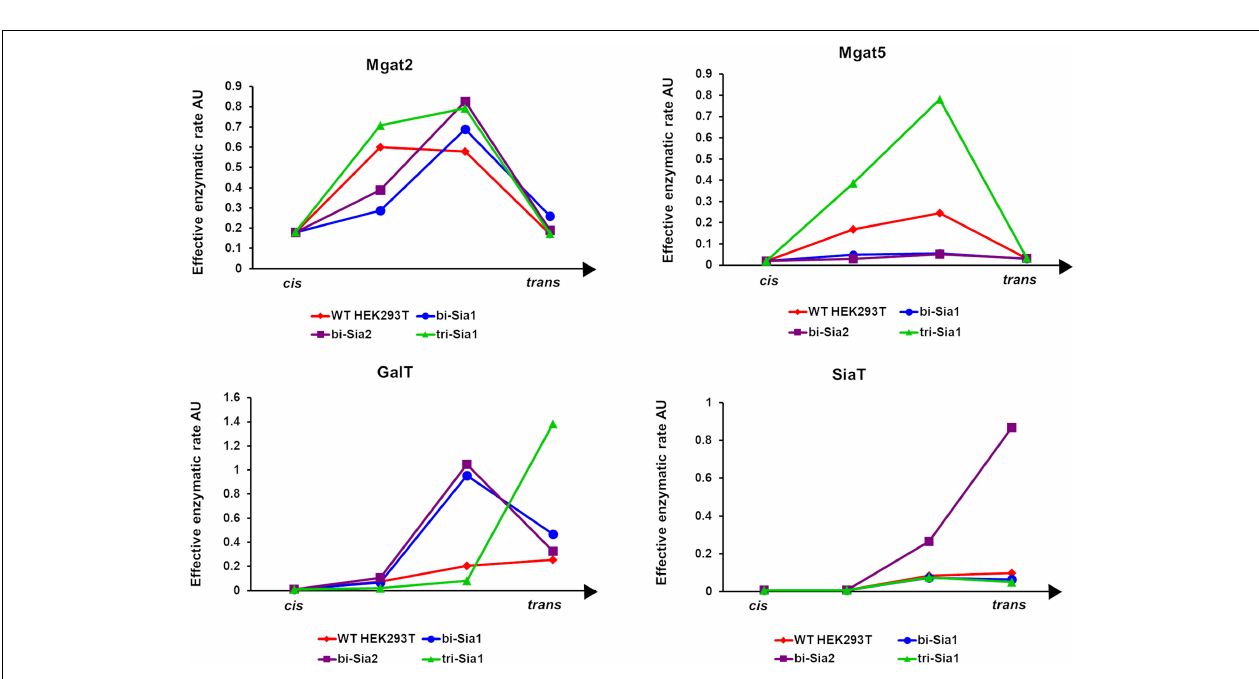
FIGURE 4 | Optimized Golgi distribution of enzymes to maximize the relative abundance of target glycans. Distributions of the effective enzymatic rates for the indicated enzymes throughout the Golgi apparatus following fitting with variable enzyme localization to maximize the abundance of the indicated target glycans. The predicted distribution in WT HEK293T cells (Fisher et al., 2019) is shown for